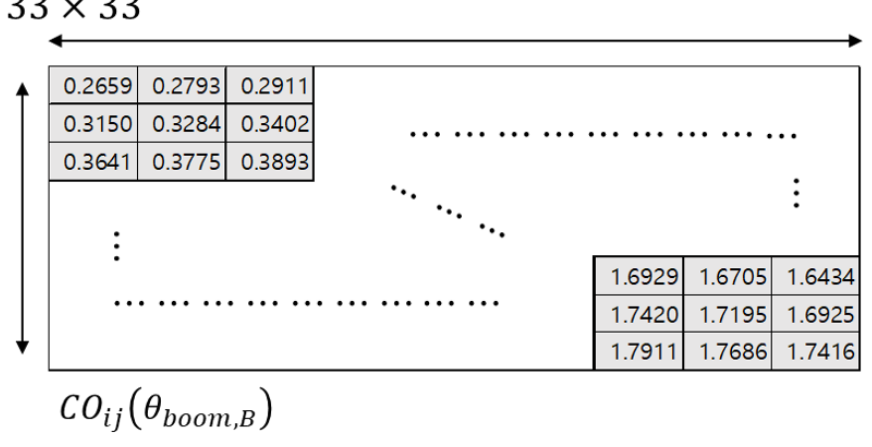
Figure 24. The 33 by 33 matrix about CO ij ( θ boom , B ) .